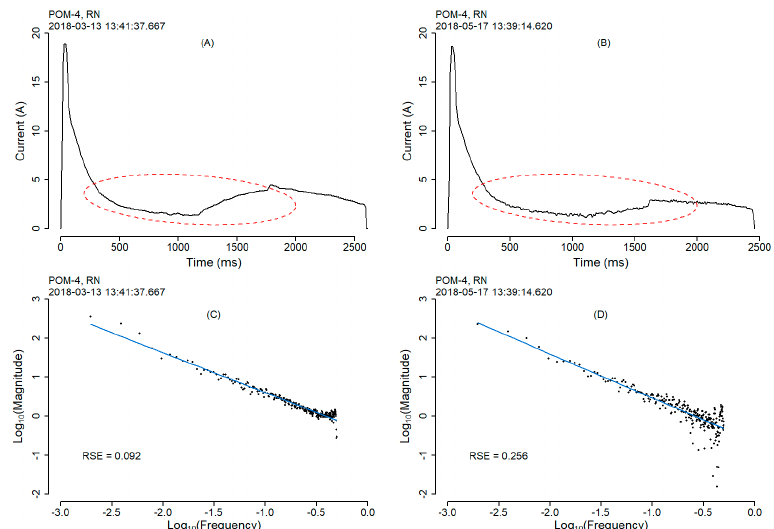
Figure 6. Actuation events of point-operating machine POM-4 in the RN direction. The events are recorded on two separate days—2018-03-13 ( A ) and 2018-05-17 ( B )—with their FFT log 10 transformation and linear curve from each event directly below ( C , D ). The red ellipse ( A , B ) highlights the area of the two actuation events that show variability in the signal, which is reflected in the observed RSE values.